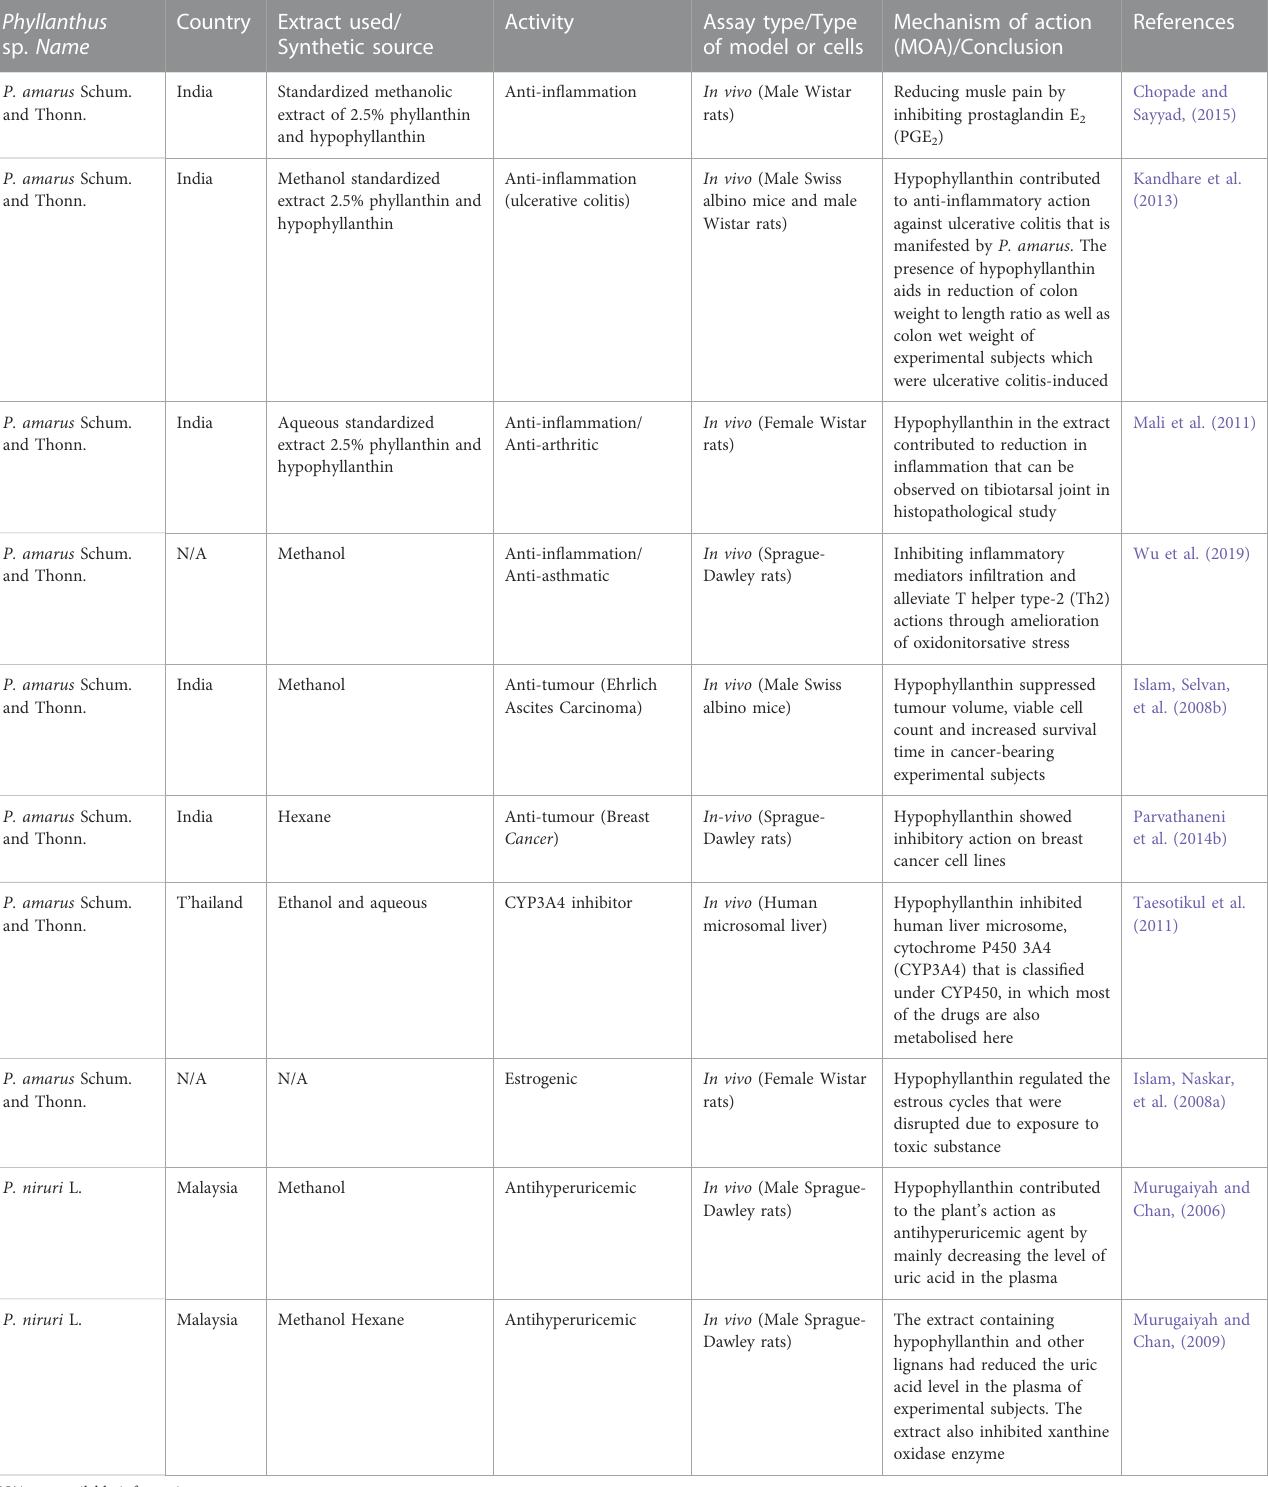
TABLE 3 In vivo pharmacological activities of hypophyllanthin and extracts of Phyllanthus species containing hypophyllanthin. Phyllanthus sp.